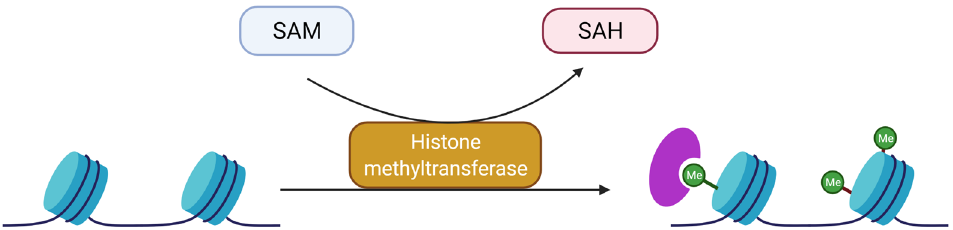
Figure 4. Overview of the mechanism of histone methylation by a methyltransferase. S-adenosyl-L-methionine (SAM) is the methyltransferase cofactor. Following methylation, S-adenosylhomocysteine (SAH) is released and the methylated moiety is attached to Nε-Lysine. A methylation reader is represented in purple and corresponds, for example, to a chromodomain or tudor domain protein.